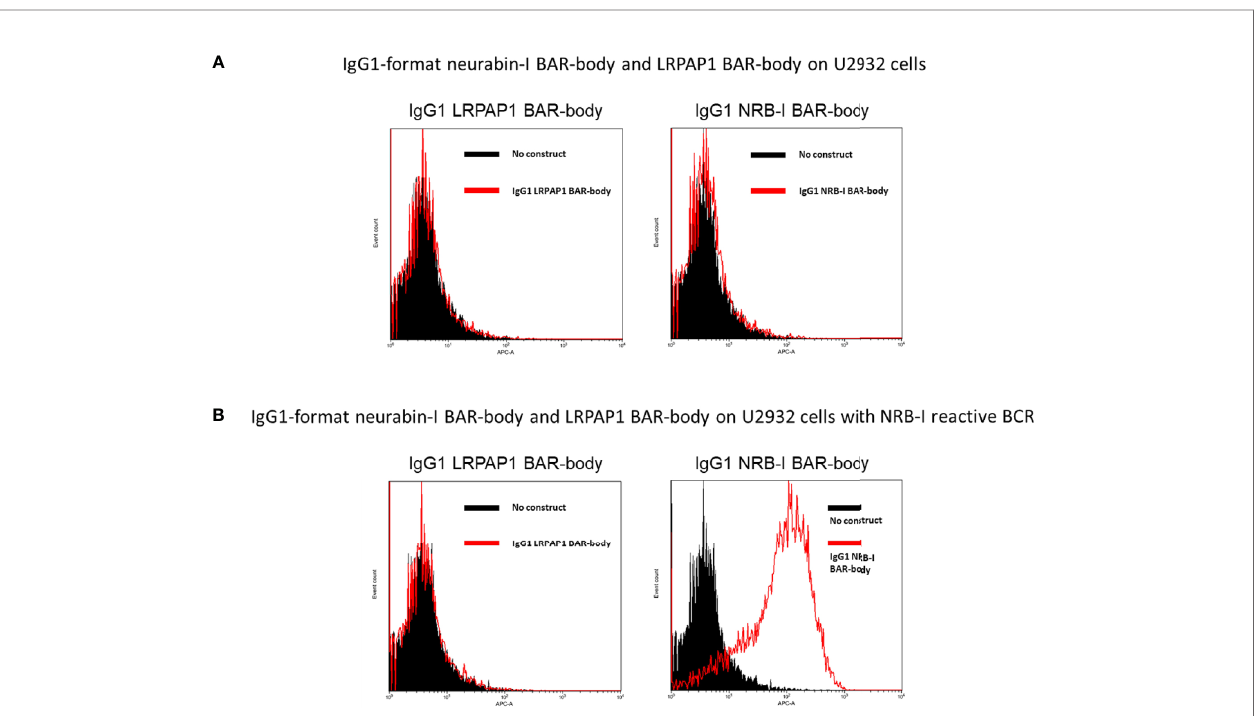
FIGURE 5 | U2932 cells (A) and U2932 cells transfected with a neurabin-I reactive BCR (B) were stained with 10 µg/ml IgG1-format neurabin-I BAR-body. Mouse anti-Flag antibody followed by APC-conjugated anti-mouse antibody were used for detection. IgG1-format BAR-bodies incorporating LRPAP1, an irrelevant BCR antigen of mantle cell lymphomas, served as controls (left histograms of A, B